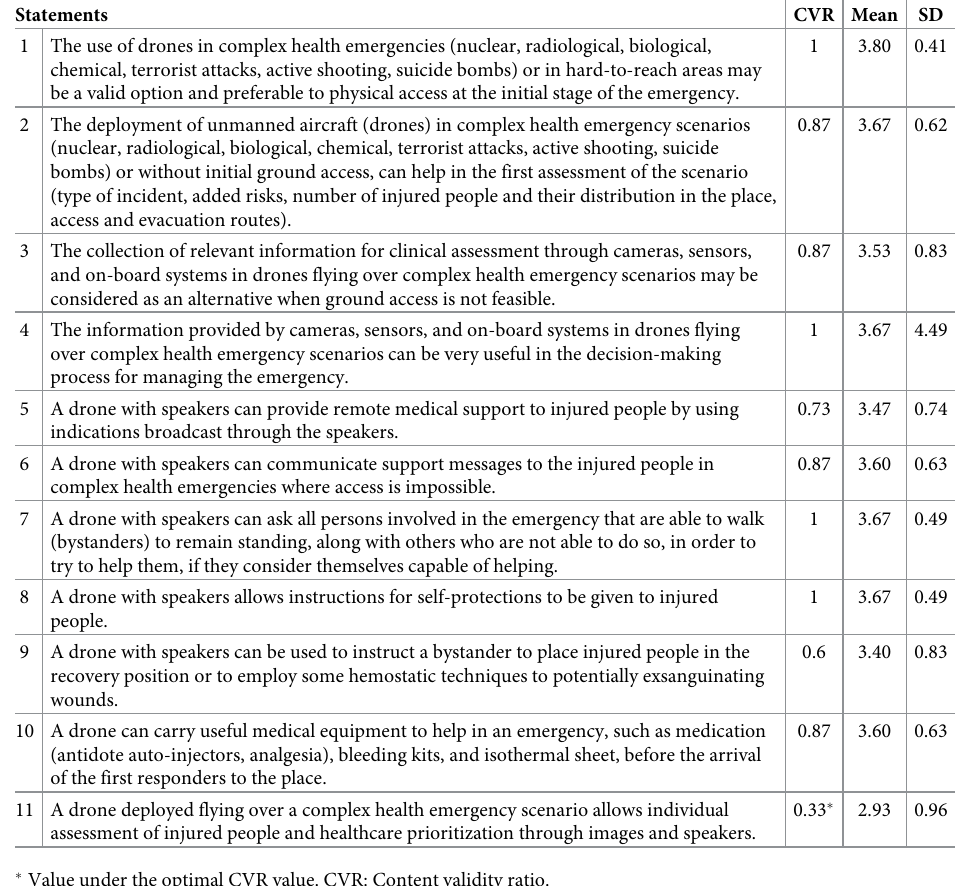
Table 2. Content evaluation of statements about the use of the drones in health